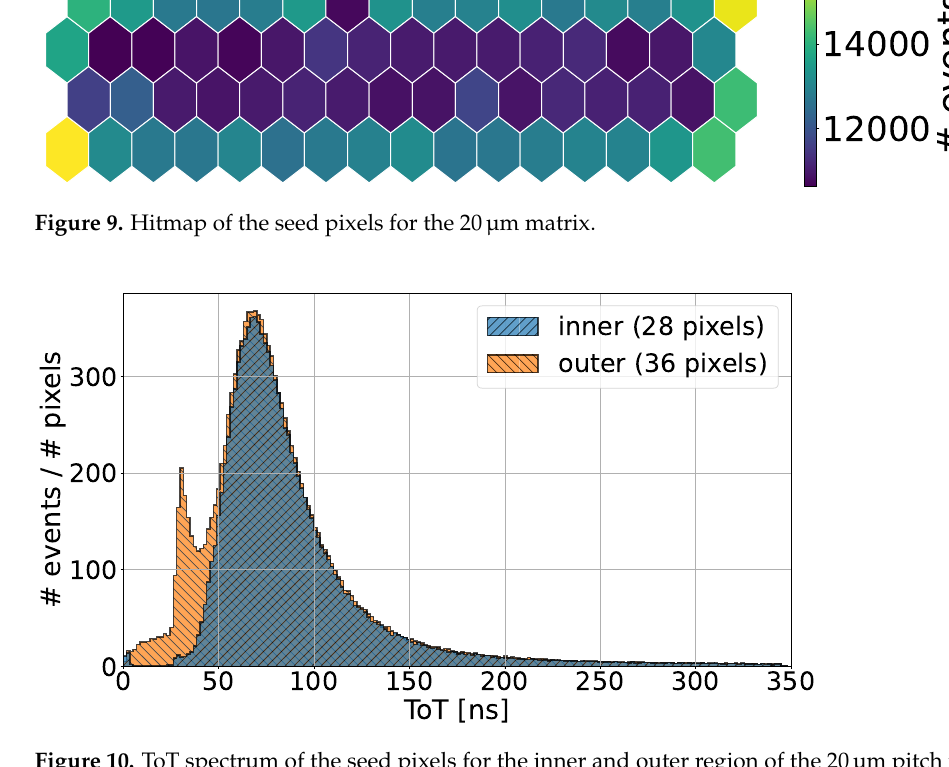
Figure 10. ToT spectrum of the seed pixels for the inner and outer region of the 20µm pitch matrix, normalized to one pixel.